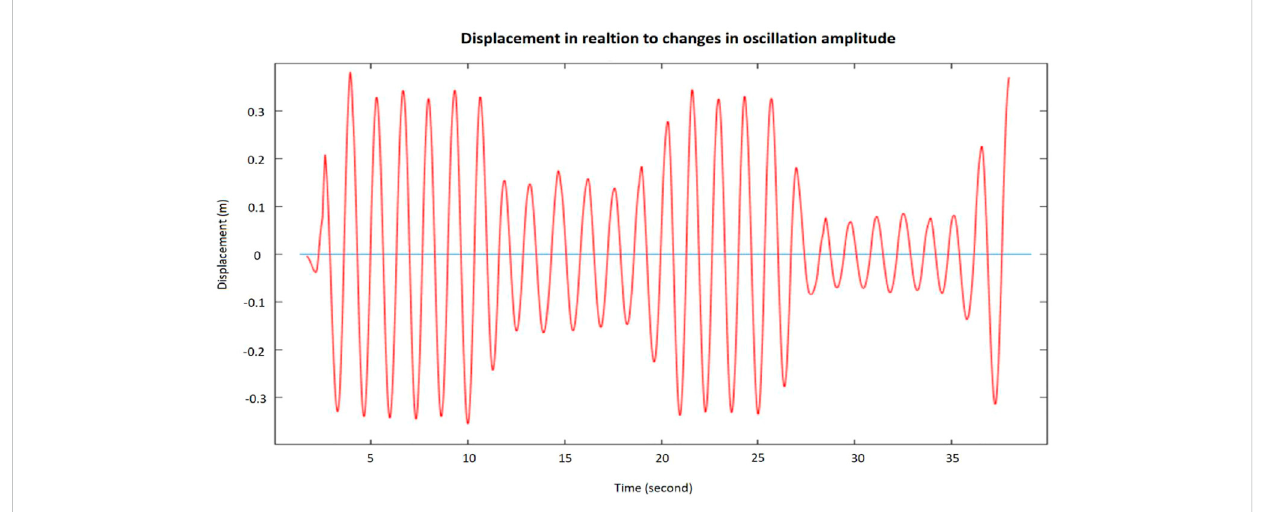
FIGURE 5 Changes in oscillation amplitude (70 cm, 35 cm, and 15